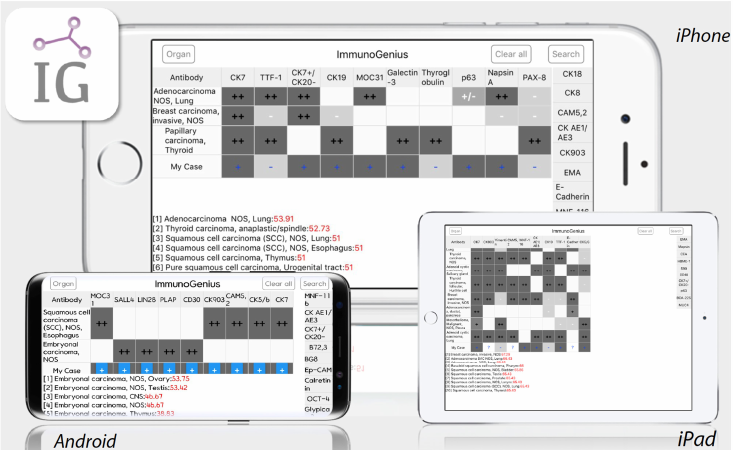
Figure 1. Machine-learning based mobile IHC interpretation supporting software,